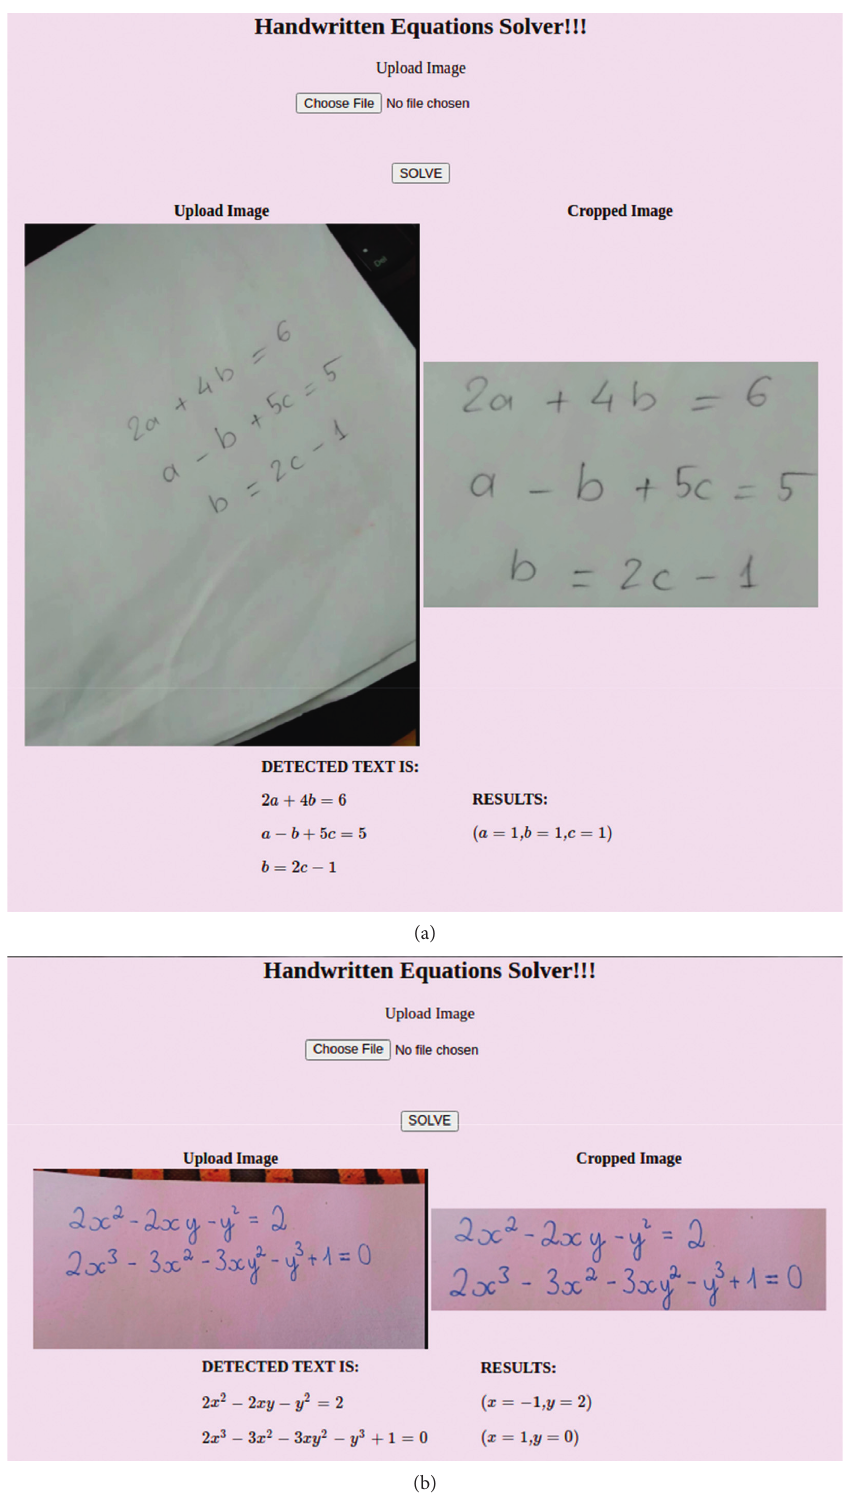
Figure 19: Deploying on the website using Flask for two cases: (a) low equation and (b) high